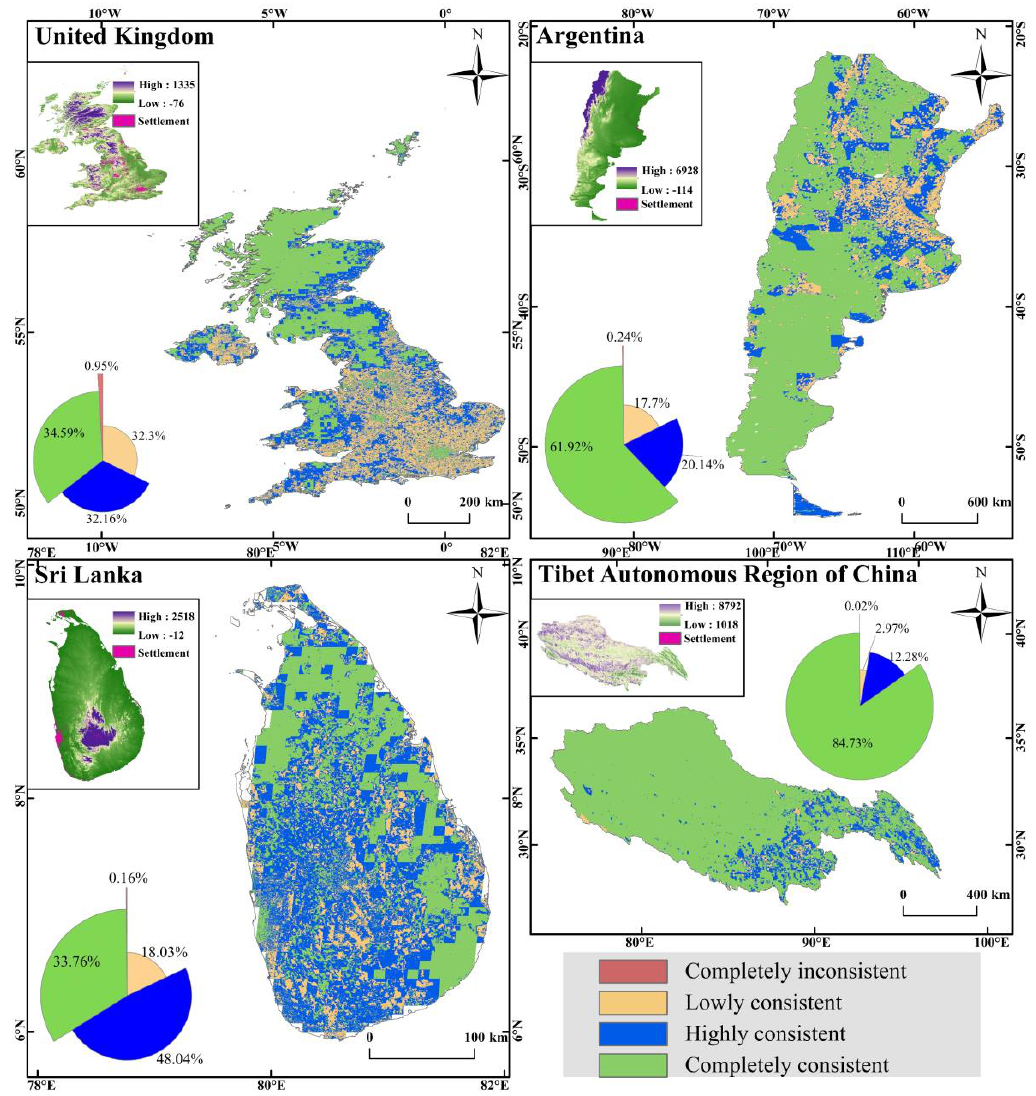
Figure 2. Spatial distribution consistency of four datasets in each case area (completely consistent: four datasets are consistent; highly consistent: three datasets are consistent; lowly consistent: two datasets are consistent; completely inconsistent: each dataset is inconsistent with the others). Table 5. Statistics of spatial distribution consistency of four sets of data.